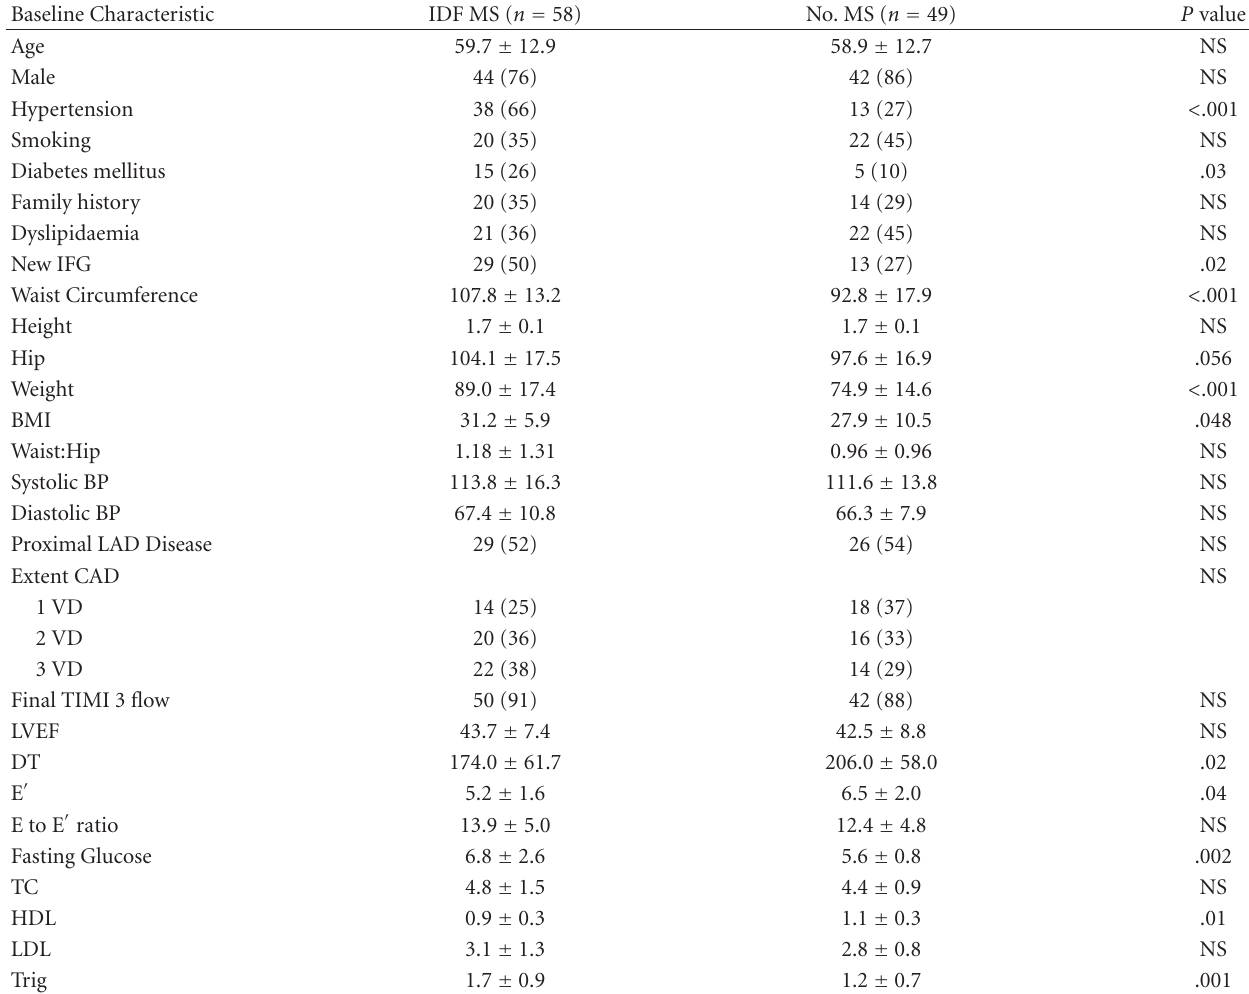
Table 2: Characteristics of patients with and without IDF